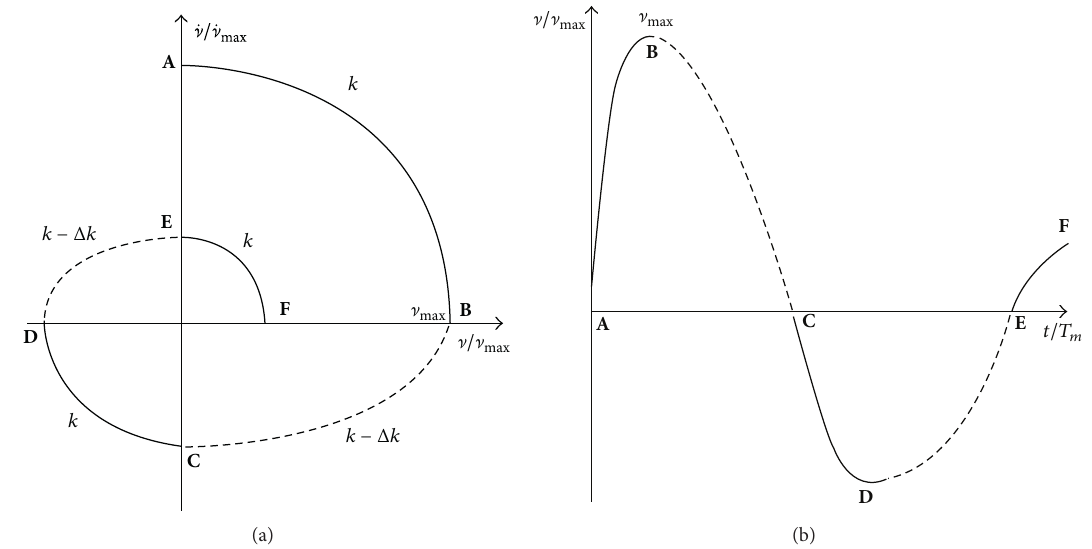
Figure 2: Free vibration of the on-off switchable system illustrating the effects of the stiffness change (— high stiffness; - - - low stiffness). (a) Phase plane plot, (b) time history of the displacement response. Response quantities have been normalized to their respective maximum values, and time is normalized considering the mean period 𝑇 𝑚 = (𝑇 on + 𝑇 off )/2 .